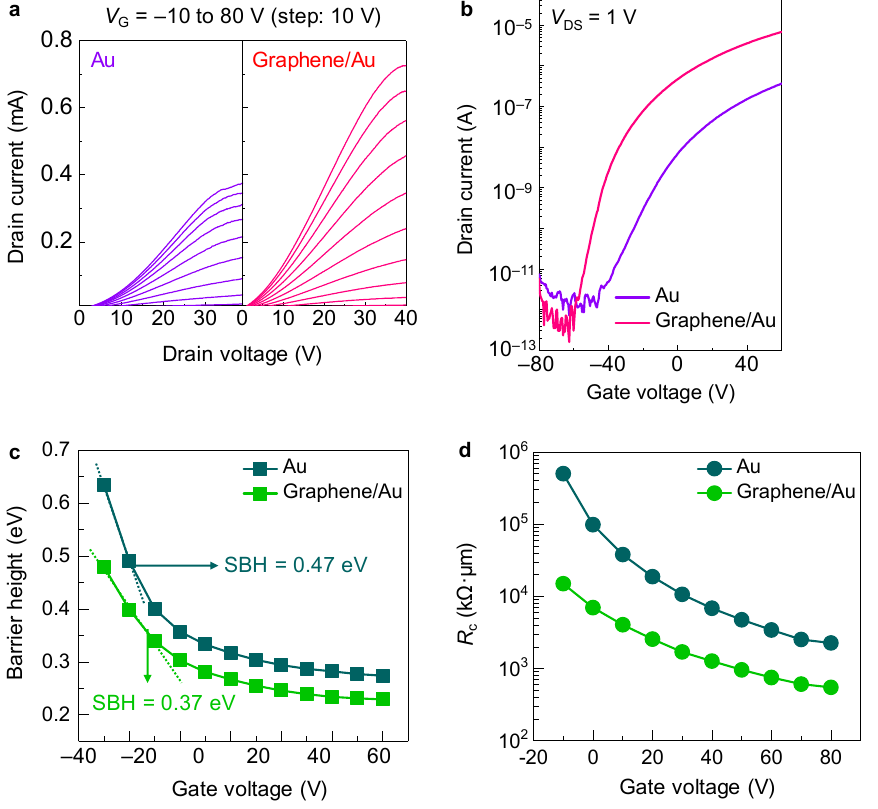
Figure 3. ( a ) Output and ( b ) transfer characterizations of MoS 2 devices with Au and graphene/Au contacts. ( c ) Barrier height and ( d ) contact resistance ( R c ) of MoS 2 devices with Au and graphene/Au contacts as a function of gate voltages.